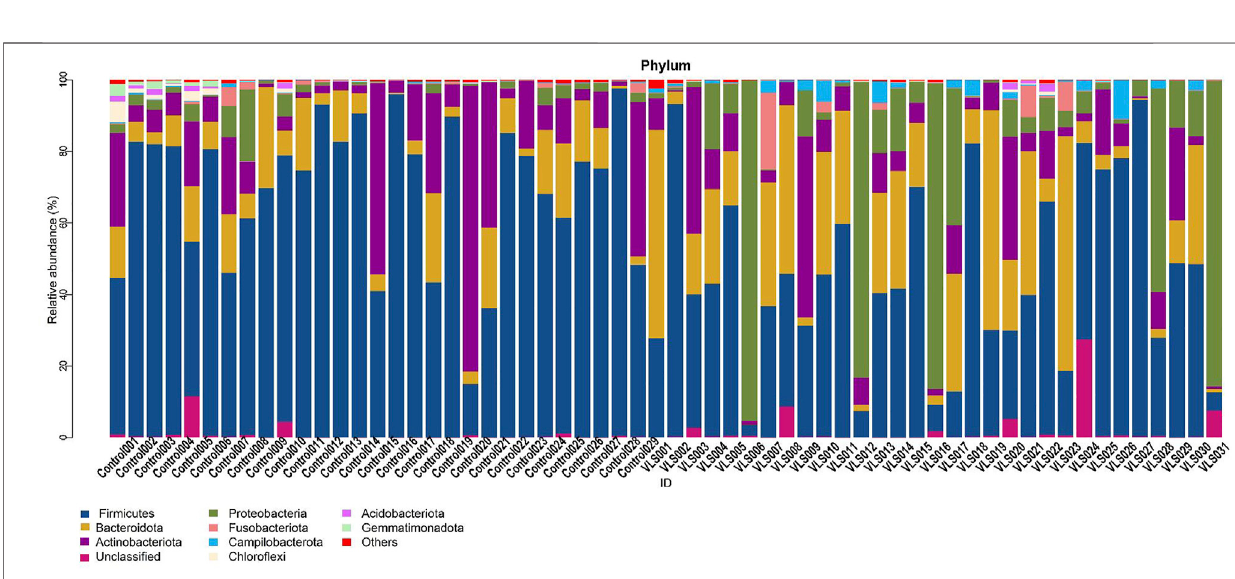
Frontiers in Cell and Developmental Biology |